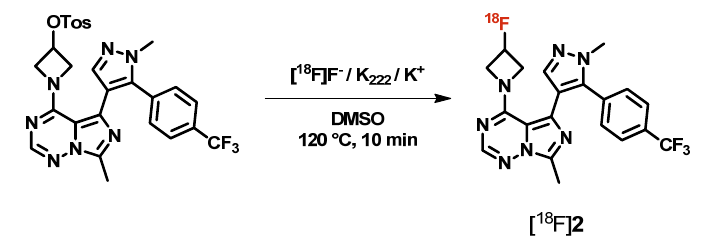
Scheme 2. Scheme 2. Radiosynthesis of [ 18 F] 2 .